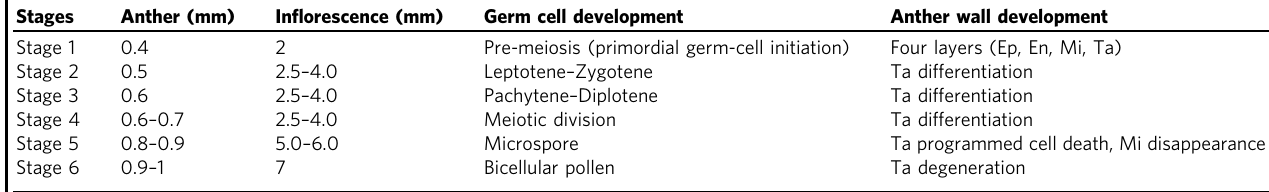
Table 1 Developmental stages of